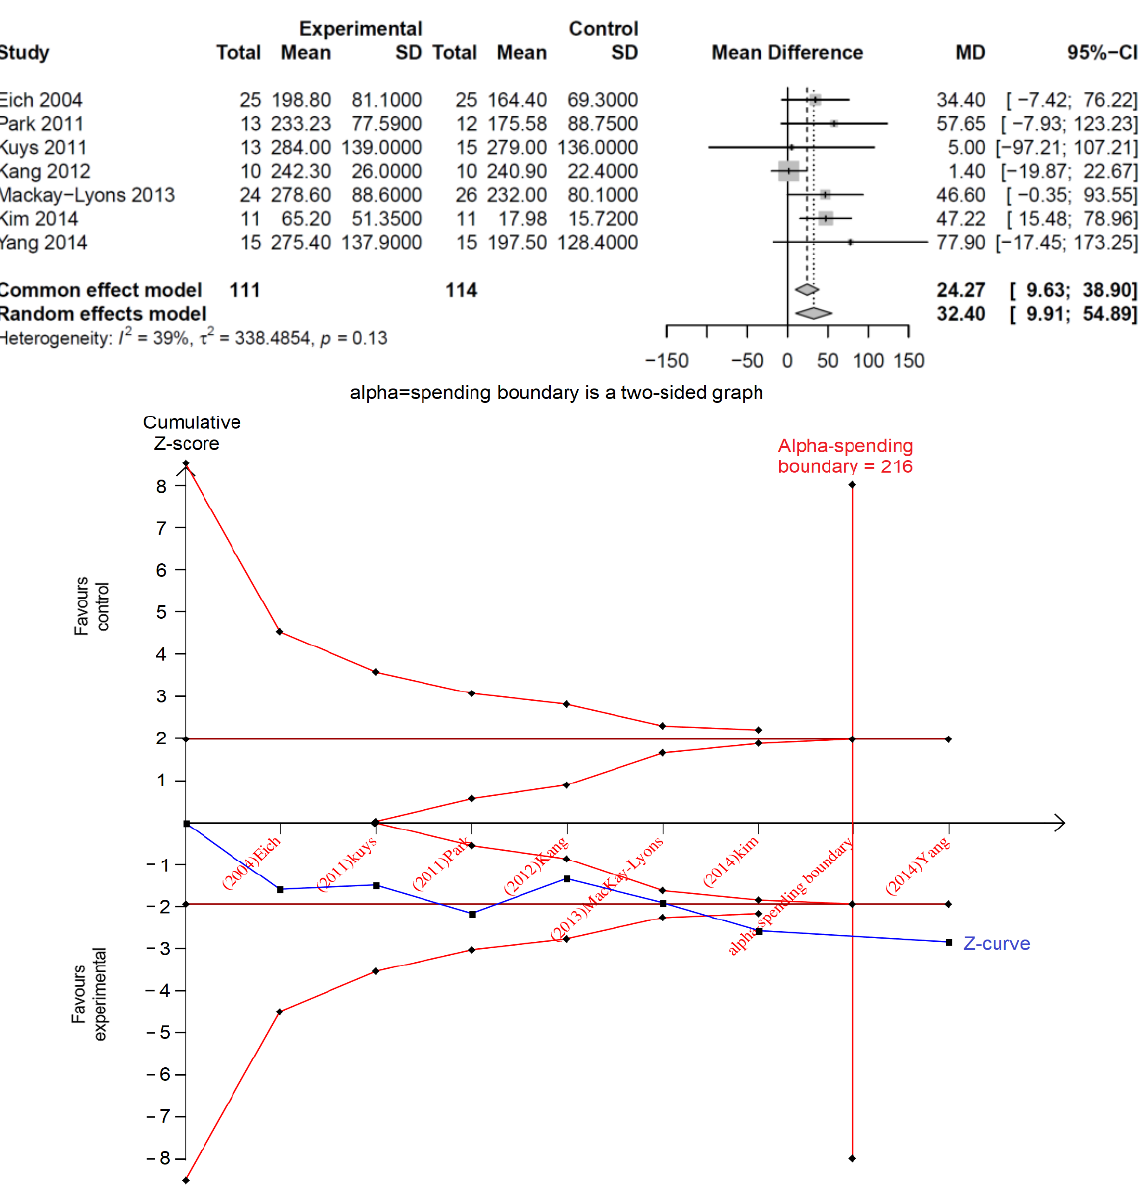
Figure 2. An illustration of a typical forest plot in a meta-analysis in the ( top ) panel and a typical TSA plot shown ( below ) it. Data were extracted from D. H. Saunders, et al. [21].